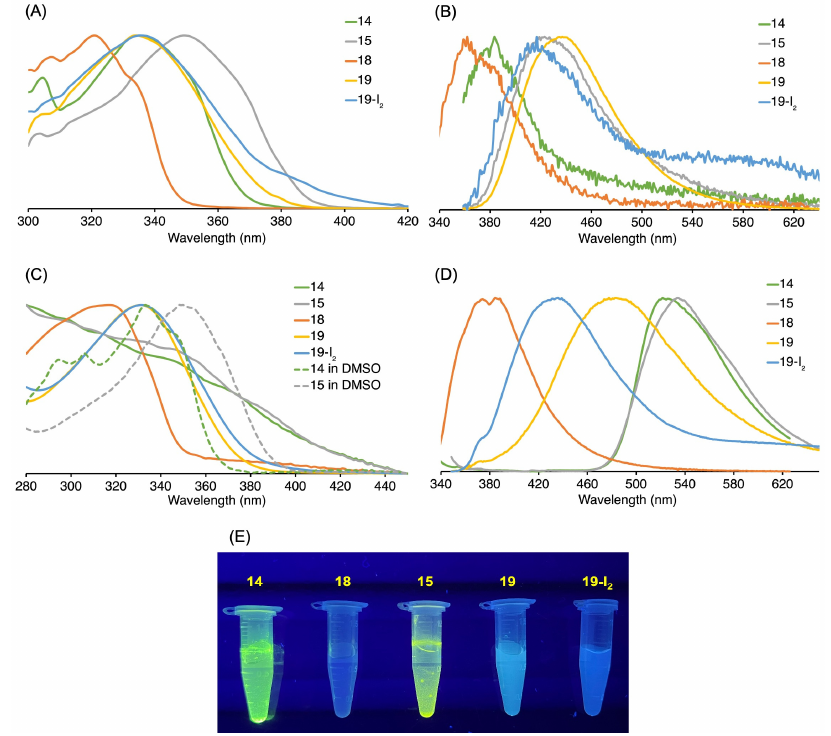
Figure 6. ( A ) Absorption spectra (normalized) at room temperature of 14 , 15 , 18 , 19 , and 19-I 2 in ethanol. ( B ) Emission spectra (normalized) at room temperature of 14 , 15 , 18 , 19 , and 19-I 2 in ethanol. Spectra were collected with a 2 nm bandpass, and 4 spectra were averaged to generate the display shown. ( C ) Absorption spectra (normalized) at room temperature of 14 , 15 , 18 , 19 , and 19-I 2 (20 μ M) in H 2 O containing 0.1% DMSO, as well as 14 and 15 (20 μ M) in 100% DMSO. ( D ) Emission spectra (normalized) at room temperature of 14 , 15 , 18 , 19 , and 19-I 2 (20 μ M) in H 2 O containing 0.1% DMSO. Spectra were collected with a 5 nm bandpass, and 20 spectra were averaged to generate the display shown. ( E ) Visualization (UV illumination) of 14 , 18 , 15 , 19 , and 19-I 2 (20 μ M) in H 2 O containing 0.1% DMSO at room temperature.